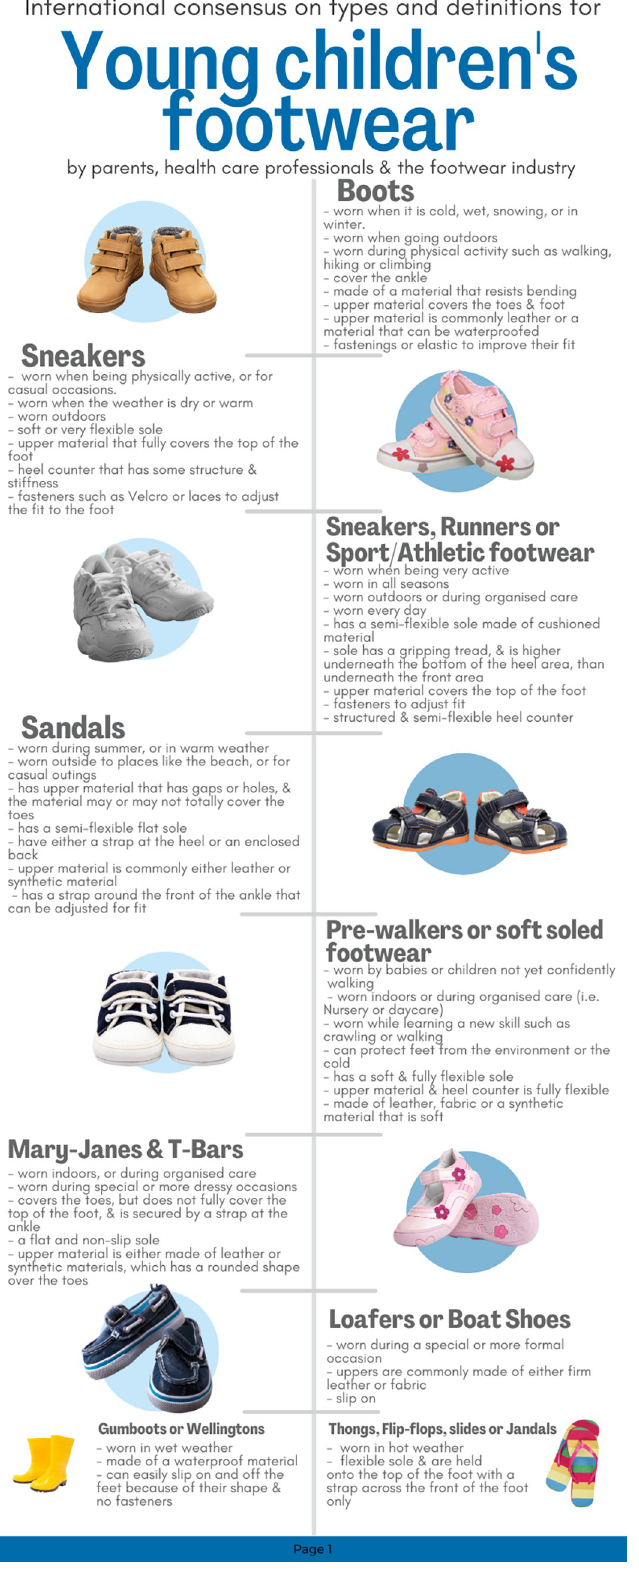
Fig 4. Taxonomy and common features